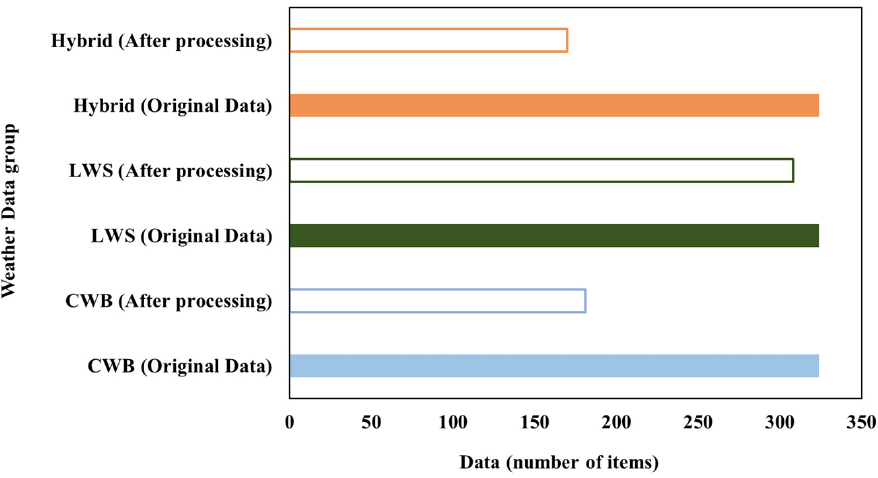
Figure 6. Missing data processing results (hollow bars: the amount of data after processing; the orange, green and blue bars are the amount of original data).